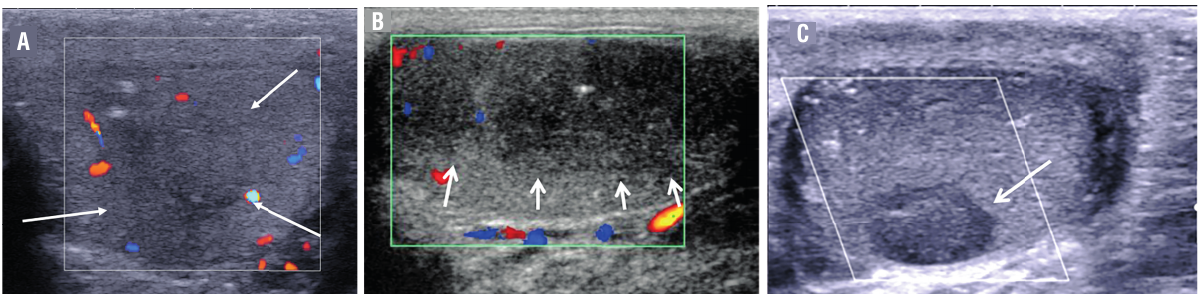
Figure 2 - Testicular Color Doppler Ultrasound of three patients (in the same order) demonstrating avascular hypoechoic areas (white arrows) with some microlithiasis suggestive of burned out